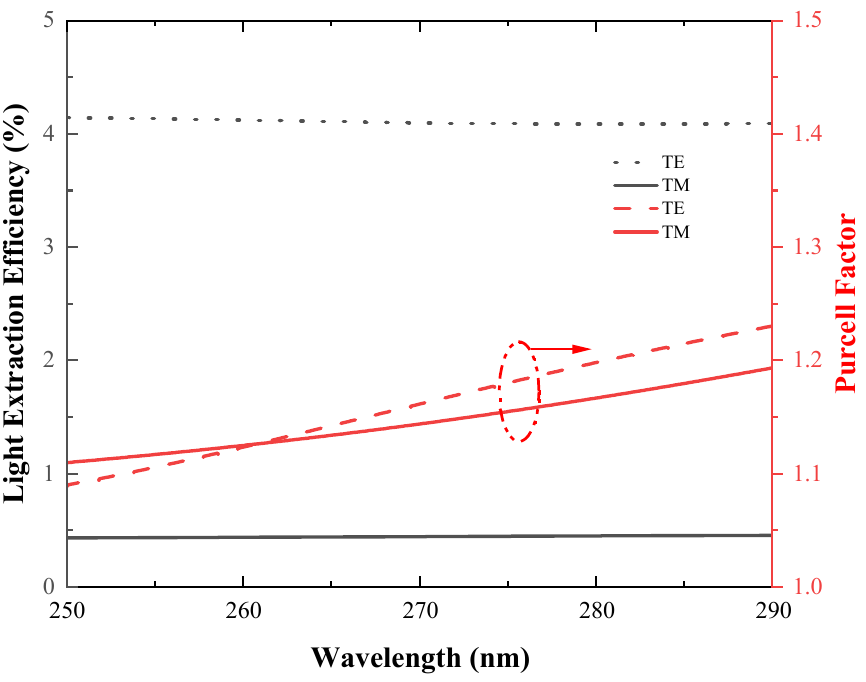
Figure 2. TE- and TM-polarized light extraction efficiency and Purcell factor within the wavelength ranging from 250 nm to 290 nm.